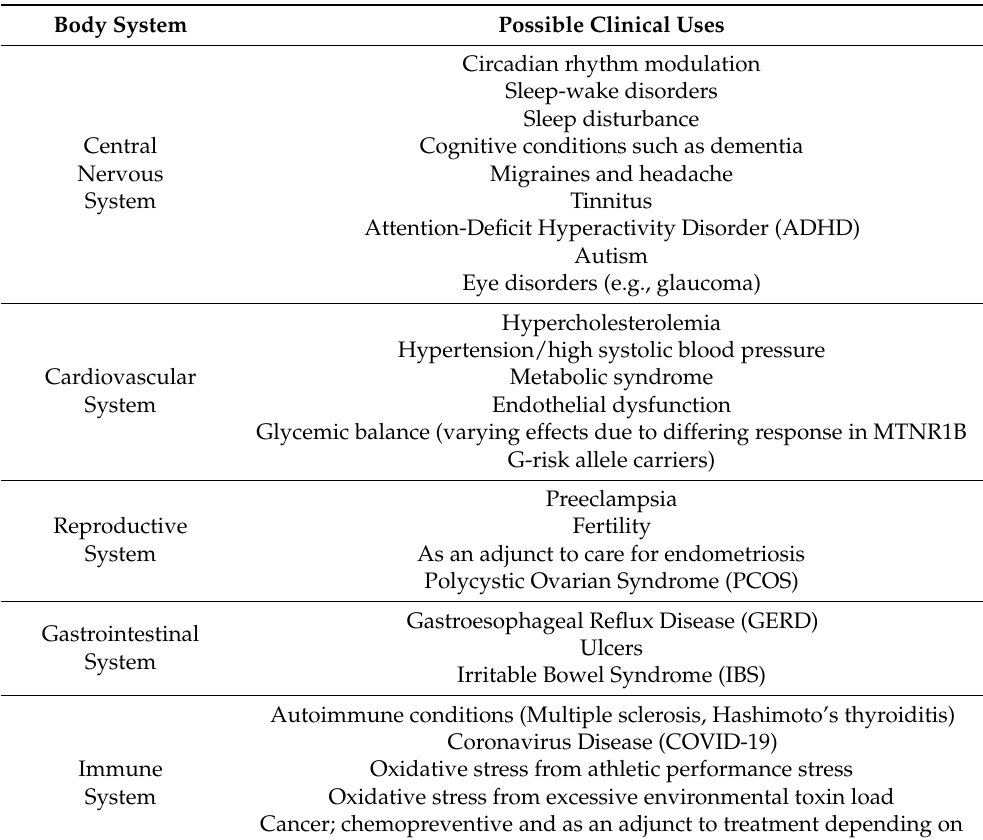
Table 2. Summary of Possible, Personalized (Select) Clinical Uses for Melatonin. Note that this list is not exhaustive; and that there are varying levels of evidence for each